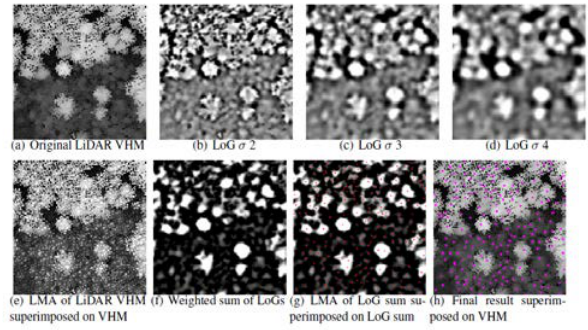
Figure 1. Processing steps and intermediate results for the LoG approach based on LiDAR nDSM